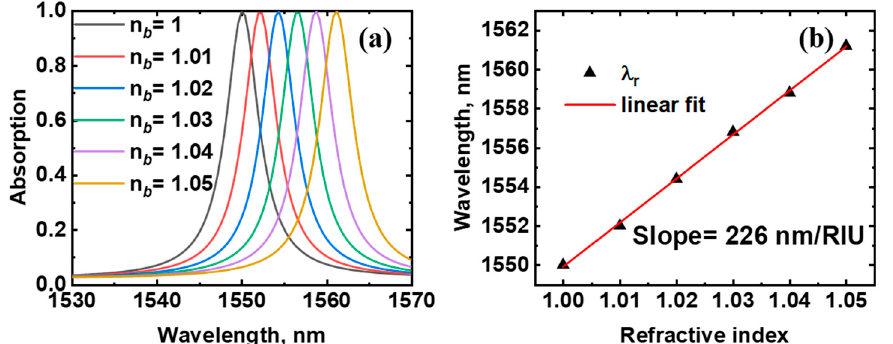
Figure 8. ( a ) Absorption spectra of the MPA with increasing the refractive index of surrounding background medium from 1 to 1.05 with step interval of 0.01. ( b ) Linear fitting of resonant absorption peak wavelength as a function of surrounding background medium’s refractive index.